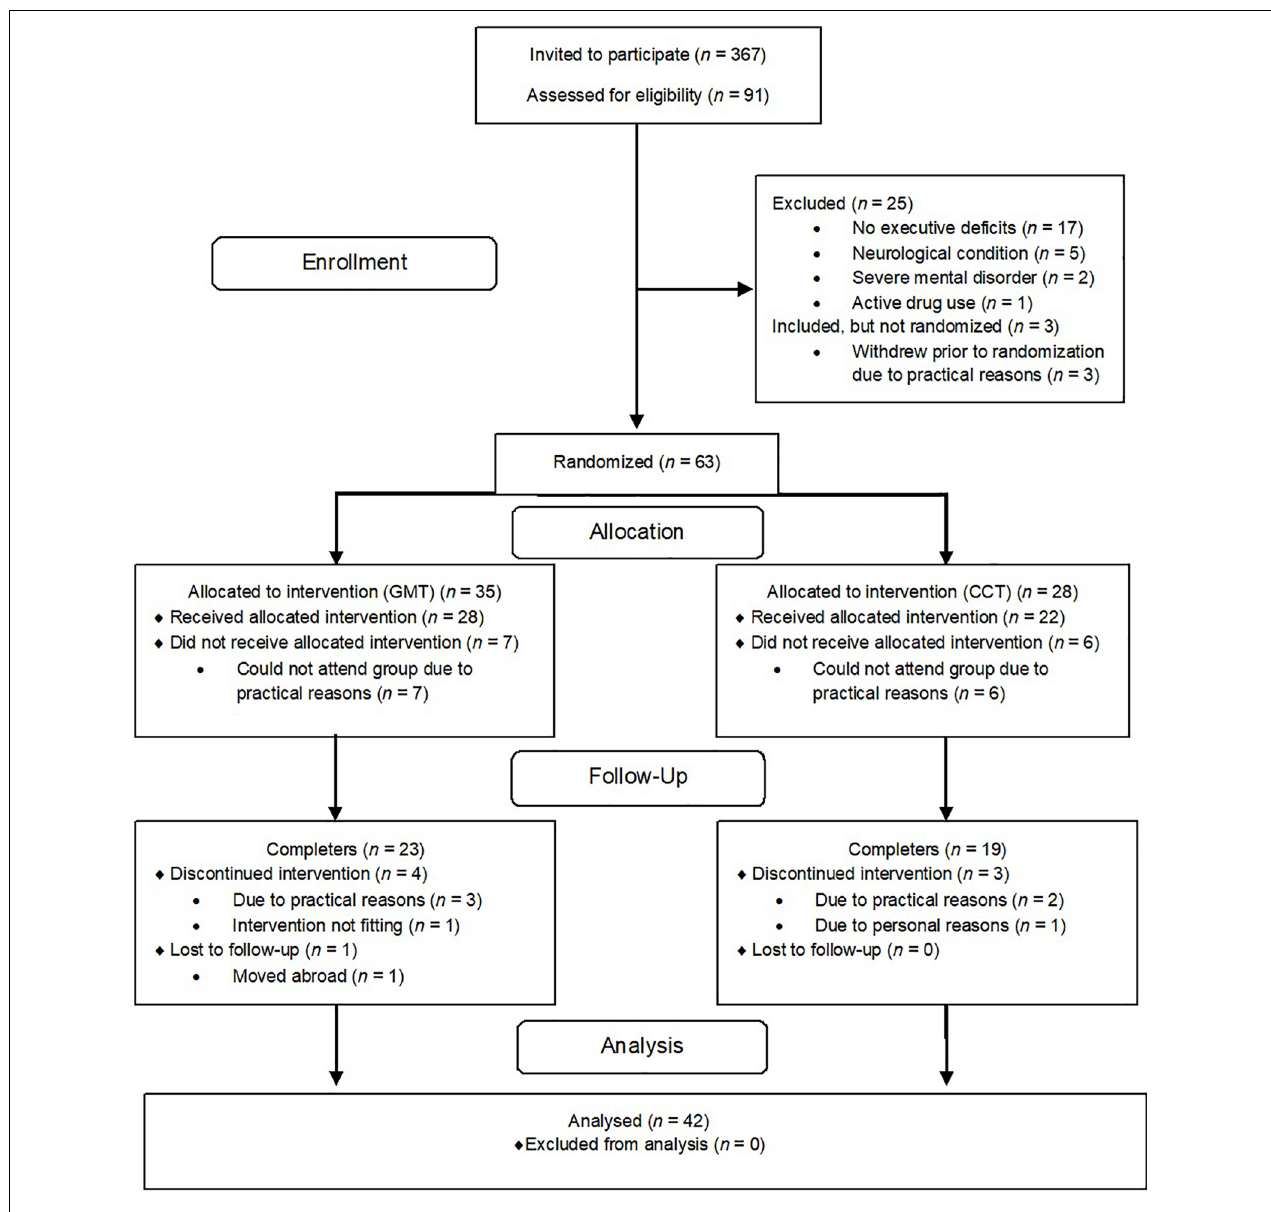
FIGURE 1 | CONSORT diagram (Schulz et al.,